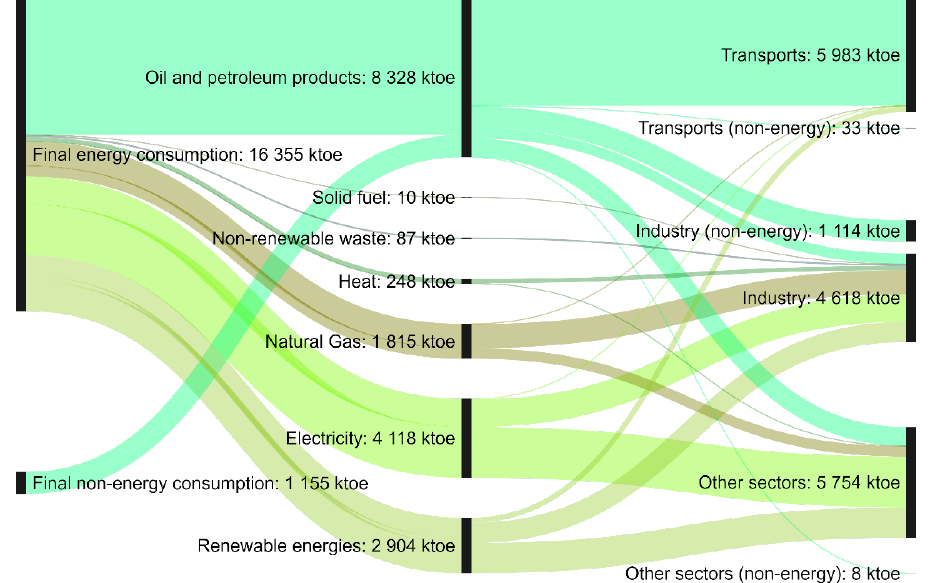
Figure 21. Portuguese energy balance of final consumption–2019 data (adopted from Eurostat data).